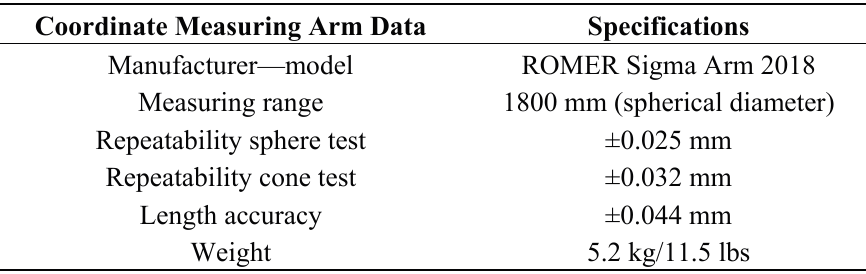
Table 1. Coordinate Measuring Arm